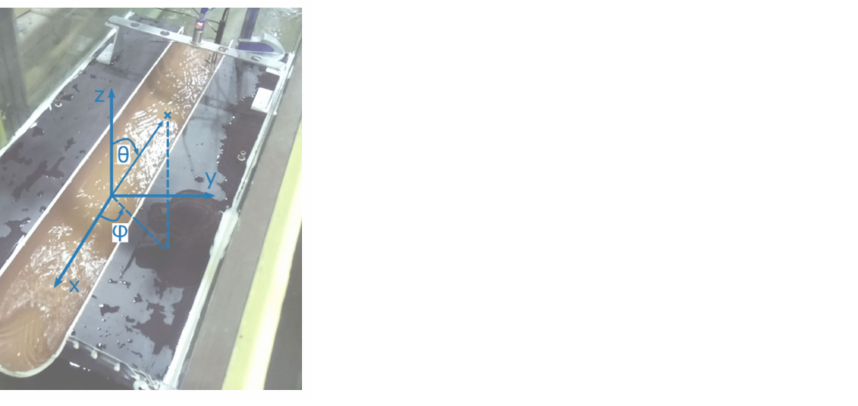
Figure 2. Laboratory setup of the open channel used for the experiments. Different camera positions are described with angles φ and θ in relation to the channel geometry. The depicted channel has a length of 1370 mm, and the half pipe has a radius of 100